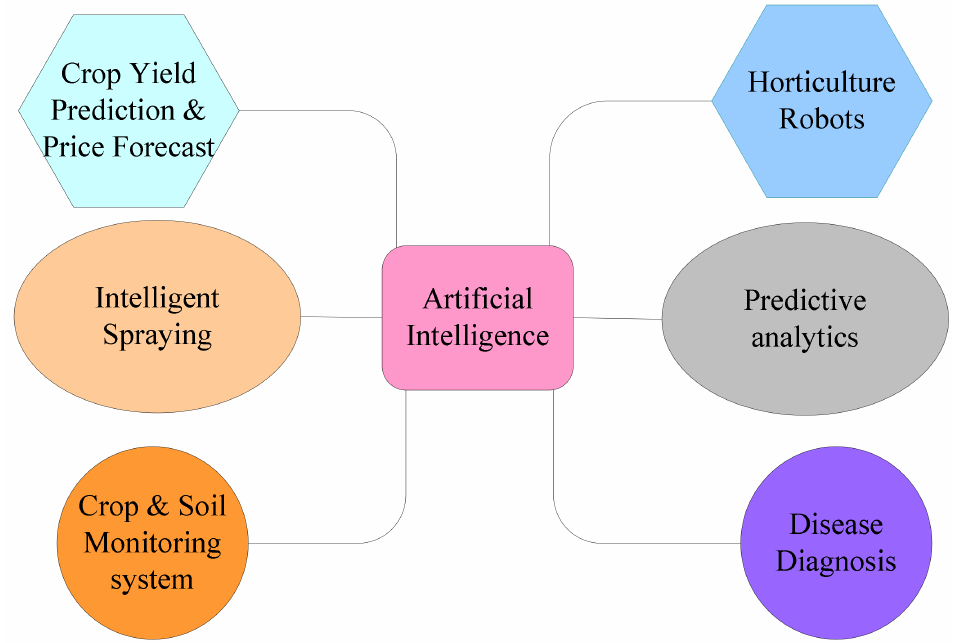
Figure 3. AI in horticulture and